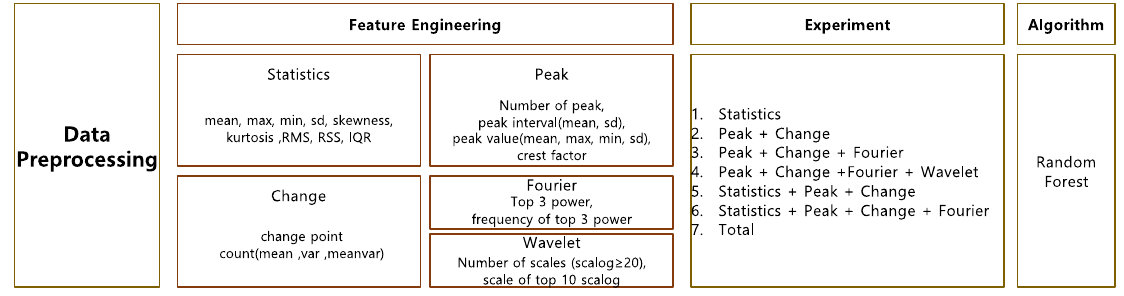
Figure 6. Research framework to build the hypotension prediction model.